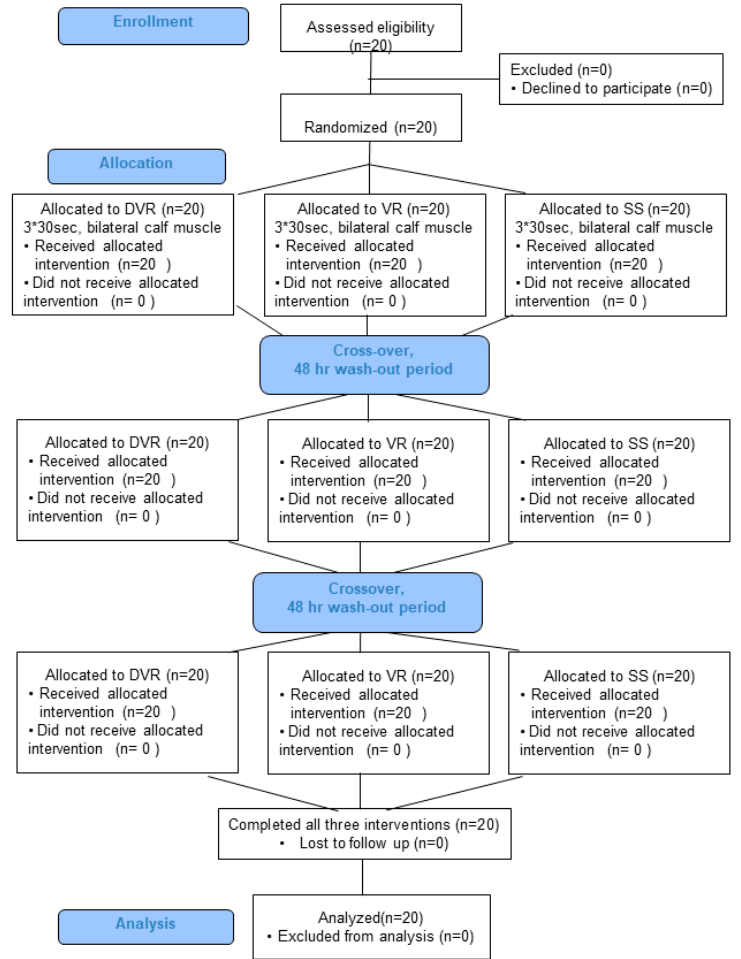
Figure 1. CONSORT flow diagram of the experimental design.